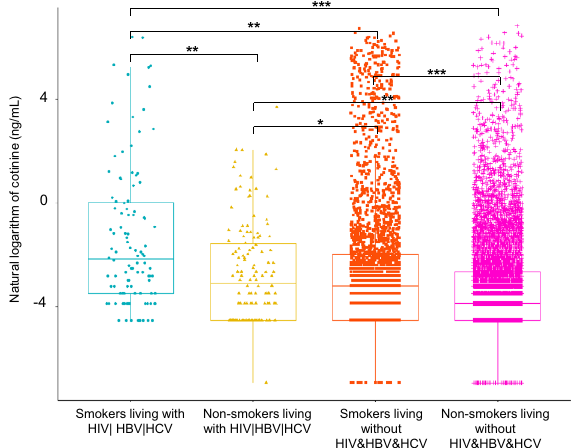
Figure 2. The distribution of serum cotinine levels in the different infection groups (*** P < 0.001; ** P < 0.01; * P <